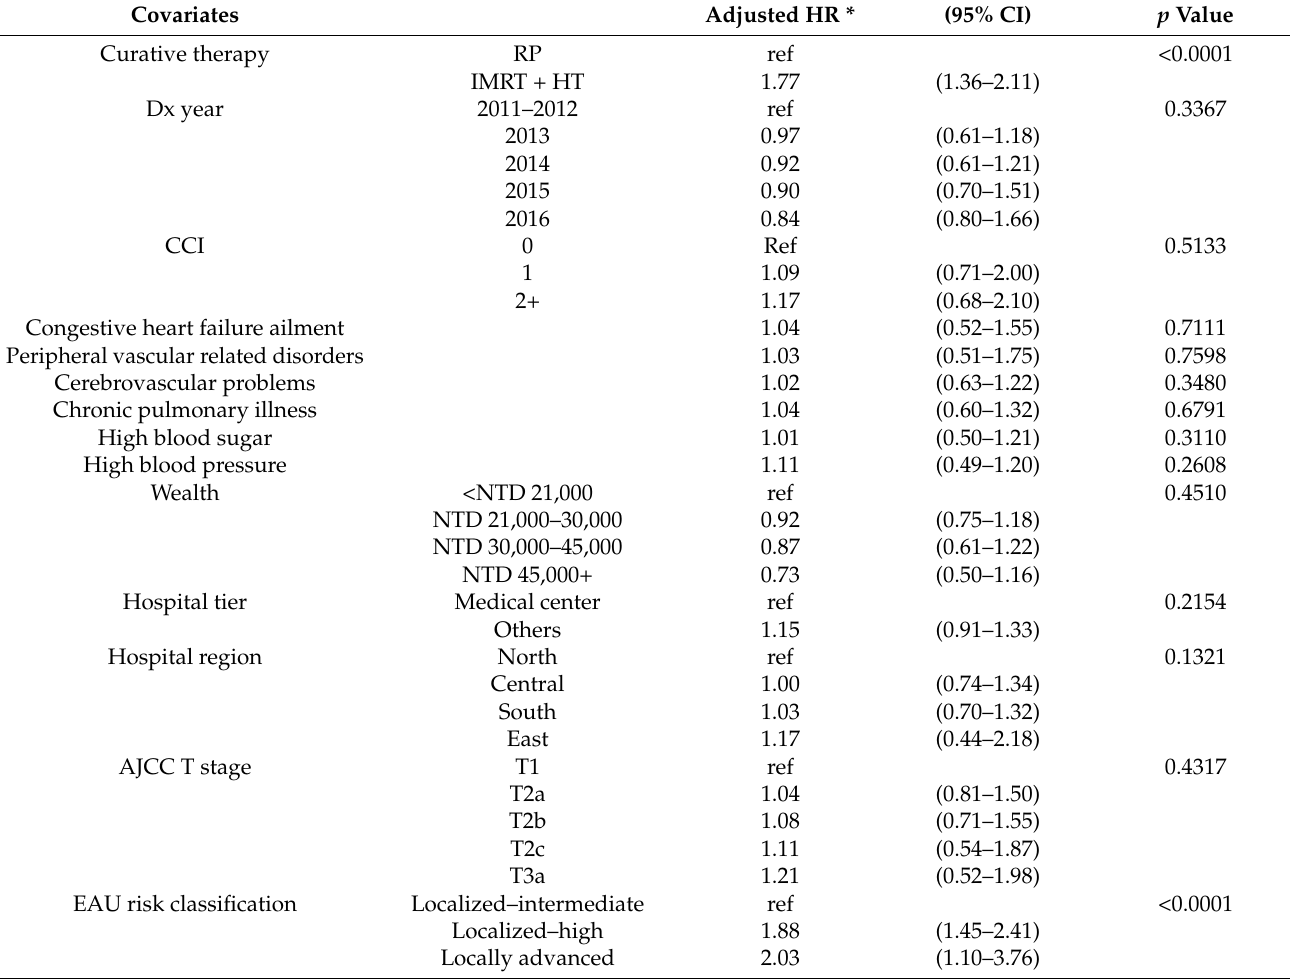
Table 2. The AV-LPC statistics of biochemical recurrence: Multivariate Cox regression